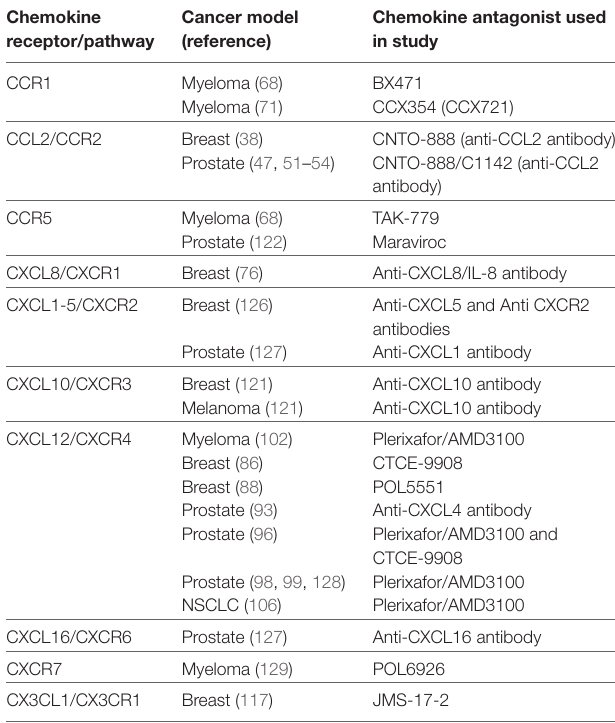
TABLe 2 | Summary of chemokine antagonists used in preclinical animal models that show efficacy in treating bone metastasis. Chemokine